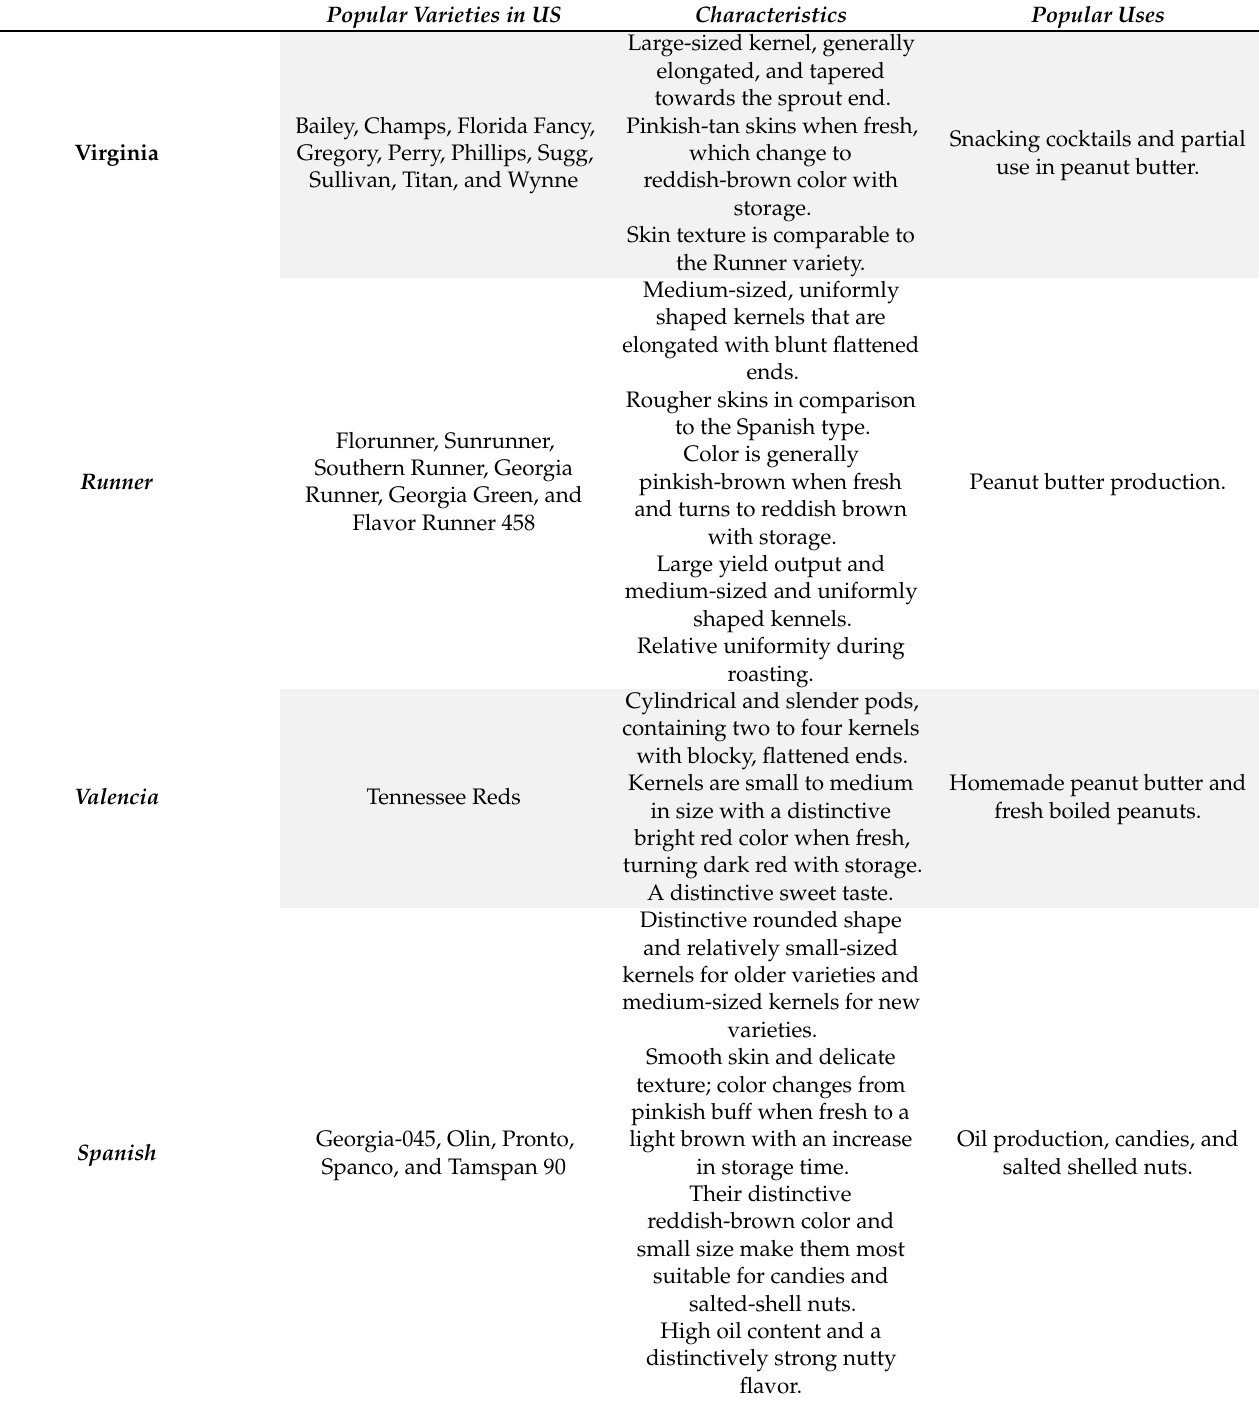
Table 1. Characteristics and uses of the most popular peanut